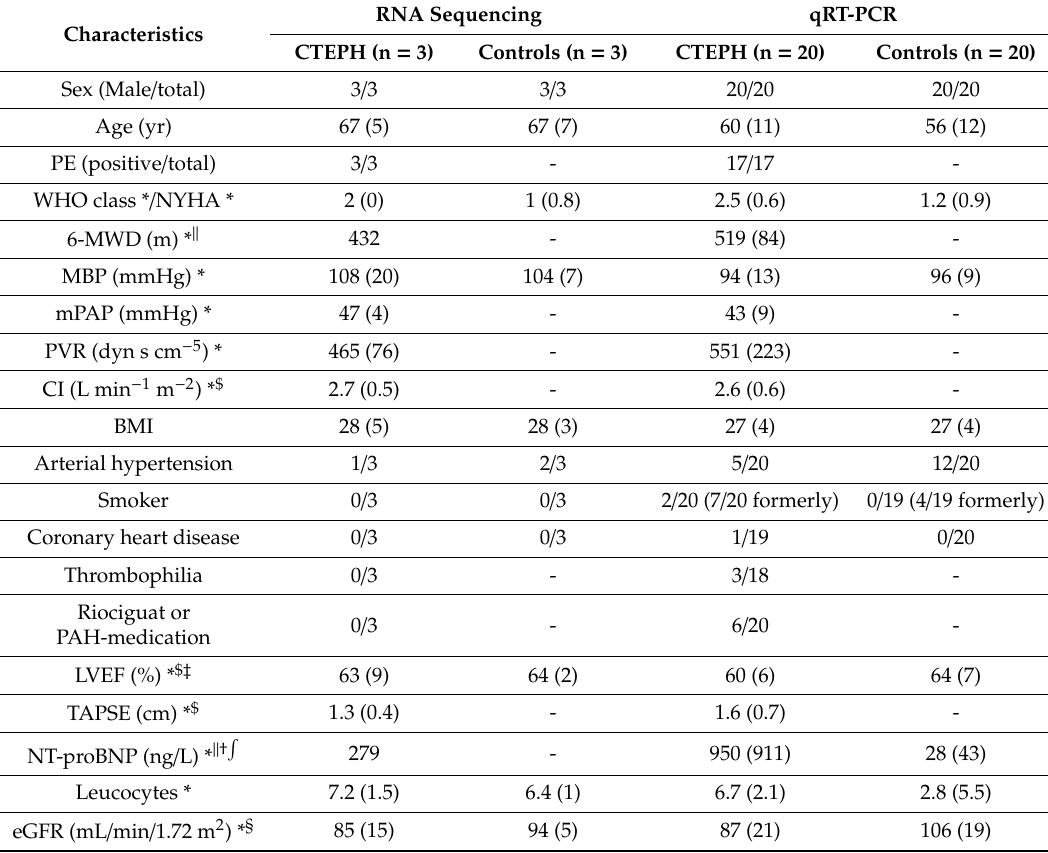
Table 1. Clinical characteristics of